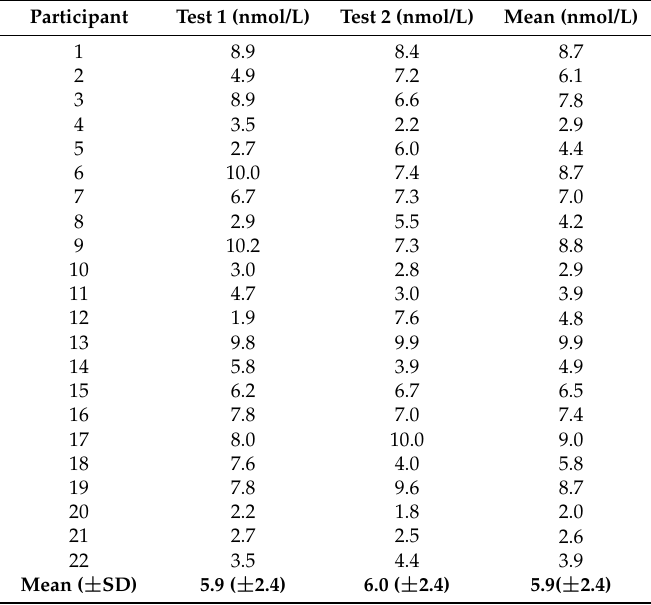
Table 1. Correlations between cortisol levels to psychological